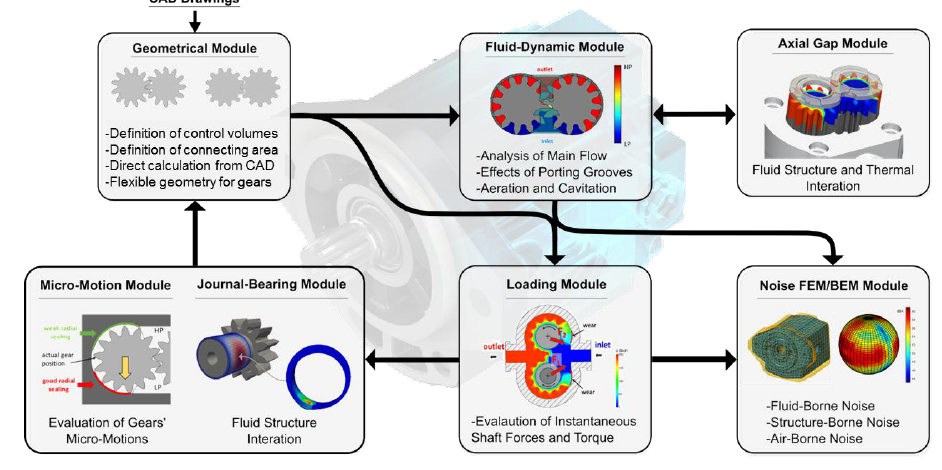
Figure 5. HYGESim model.